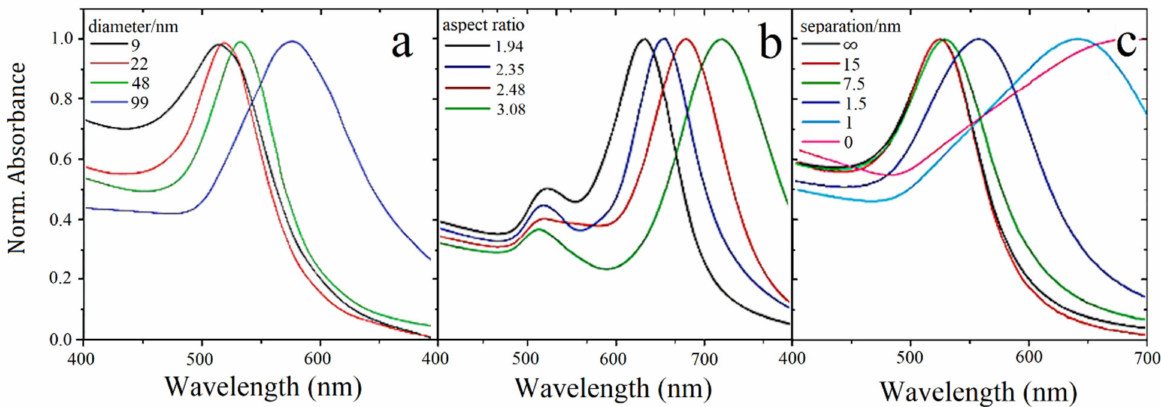
Figure 5. ( a ) NS diameter variation, ( b ) Ellipsoids of different aspect ratios, ( c ) NP volume fraction dependency. Adapted with permission from